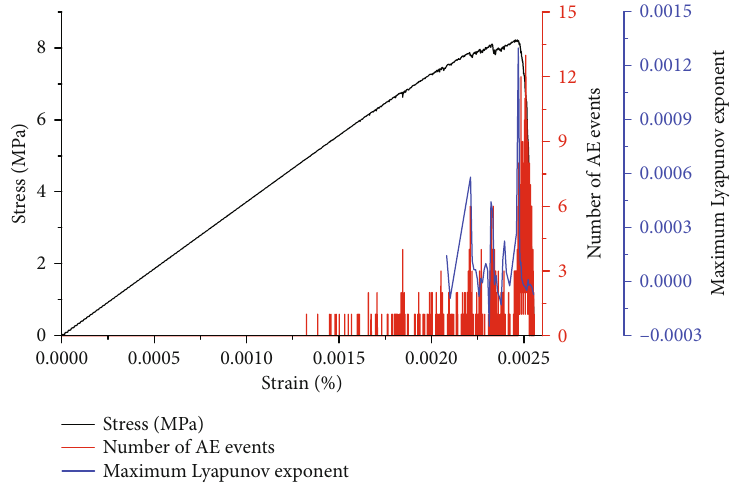
Figure 9: Stress-strain-number of AE events-maximum Lyapunov exponential variation diagram of specimen